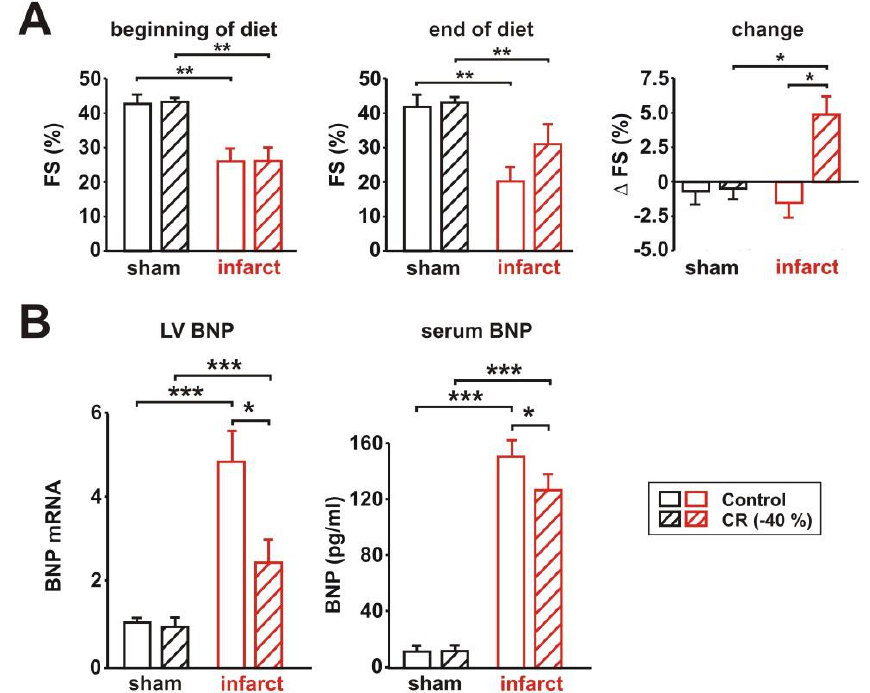
Figure 2. Effect of 8 weeks CR on LV systolic function and expression or release of brain natriuretic peptide (BNP). ( A ): LV fractional shortening (FS%) at the beginning of the diet (left panel), end of the diet (middle panel), and changes in FS during the feeding period (right panel) in sham or infarct rats following 8 weeks of control or CR diets. ( B ): LV mRNA expression (left panel) and serum levels of brain natriuretic peptide (right panel) in sham or infarct rats, following 8 weeks of control or CR diets. All data are mean ± SEM. n = 5–6 animals per group, *: p < 0.05; **: p < 0.01; ***: p < 0.001.